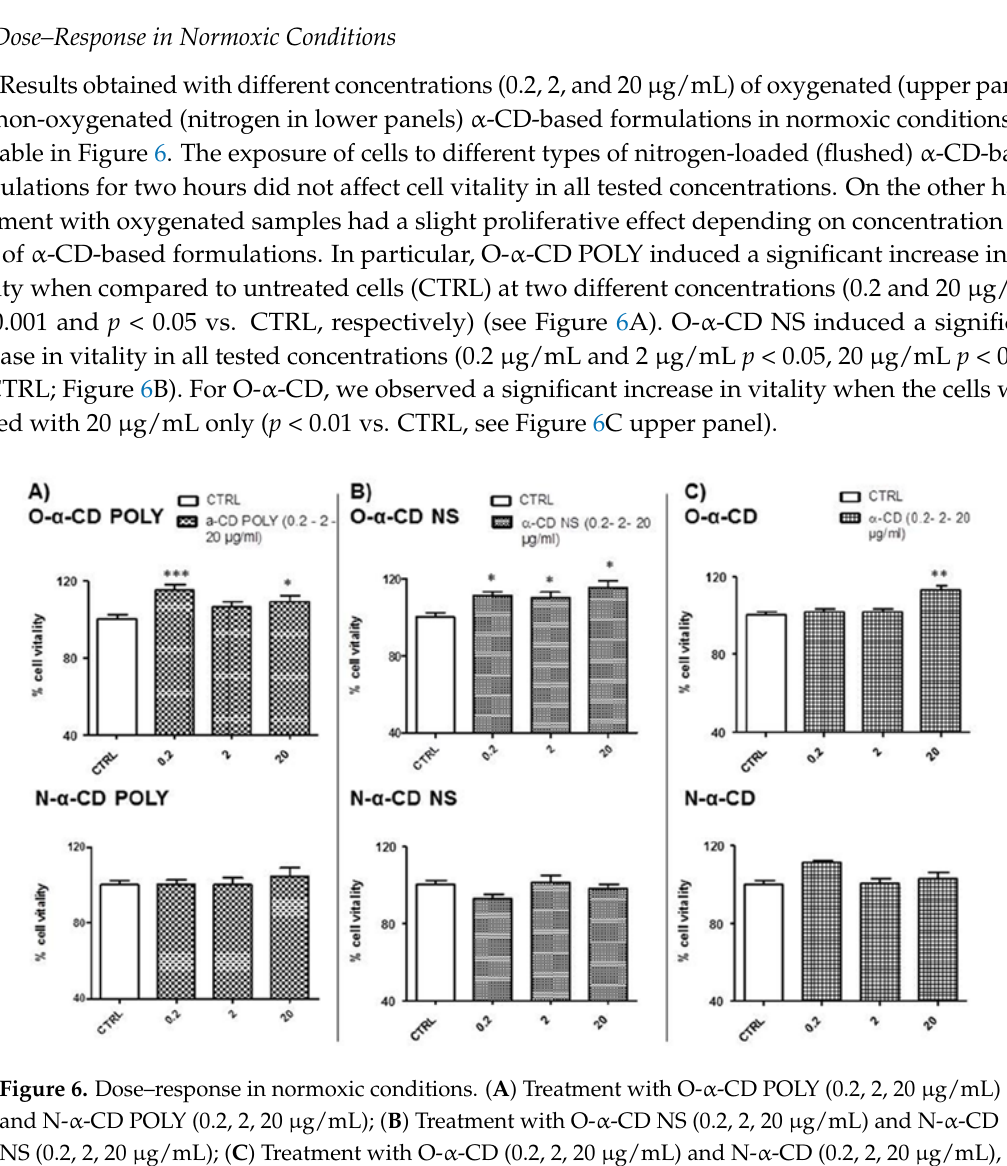
Figure 5. Zeta potential values of α-CD-based formulations in NaCl 0.9% (negative control) cell culture medium in an ischemic buffer over time. Each point represents the mean ± SD of three experiments.